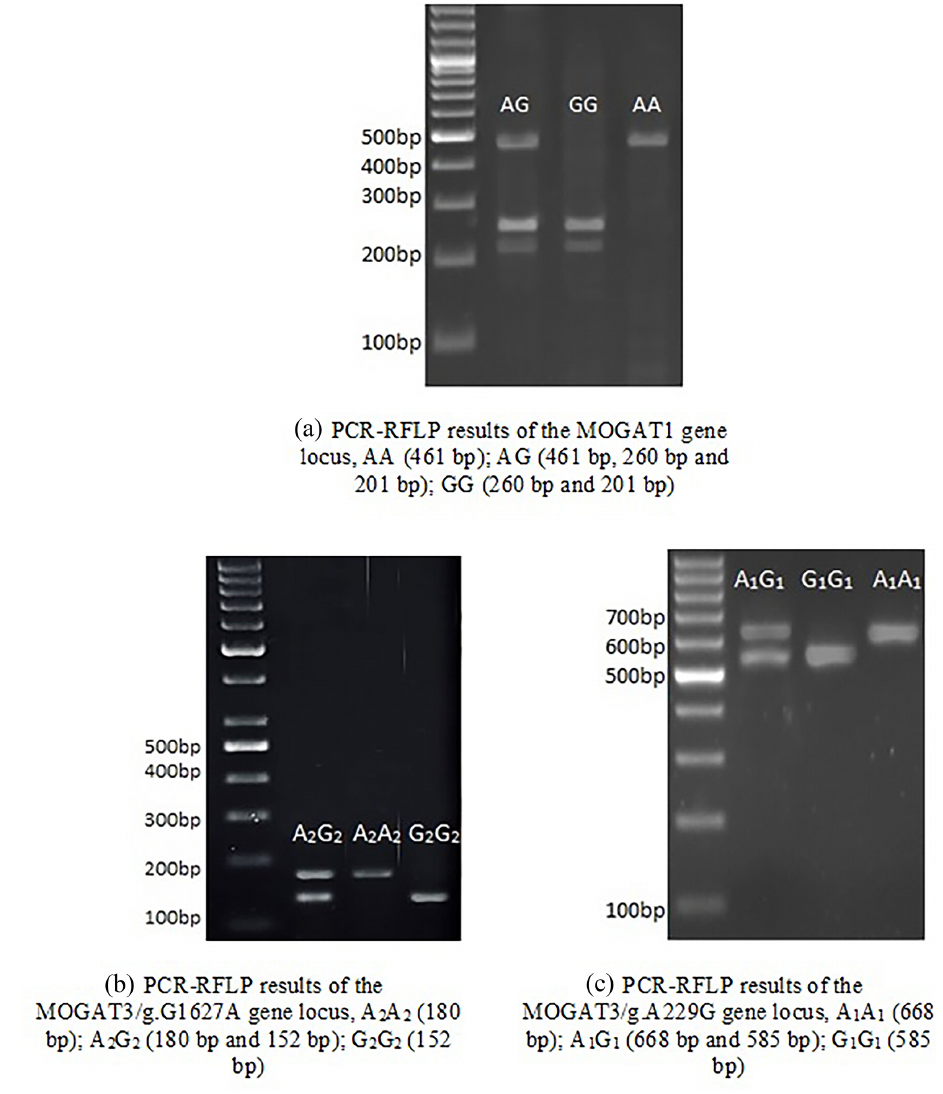
Figure 1. Agarose gel electrophoresis